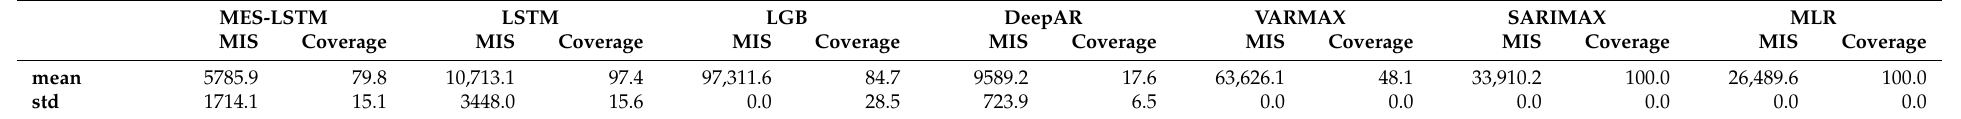
Table 11. Prediction Interval Accuracy Distribution for All Trials for total deaths in South Africa ( α = 0.05).